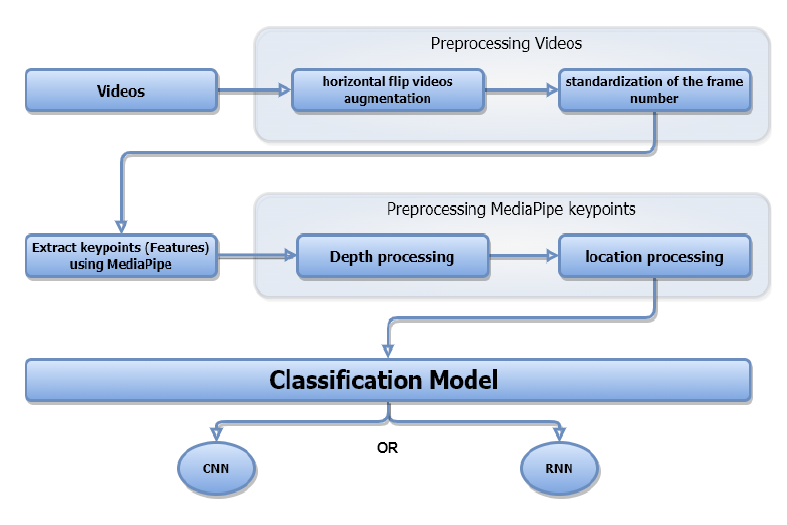
Figure 1. Overview of our proposed Dynamic Sign Language Recognition